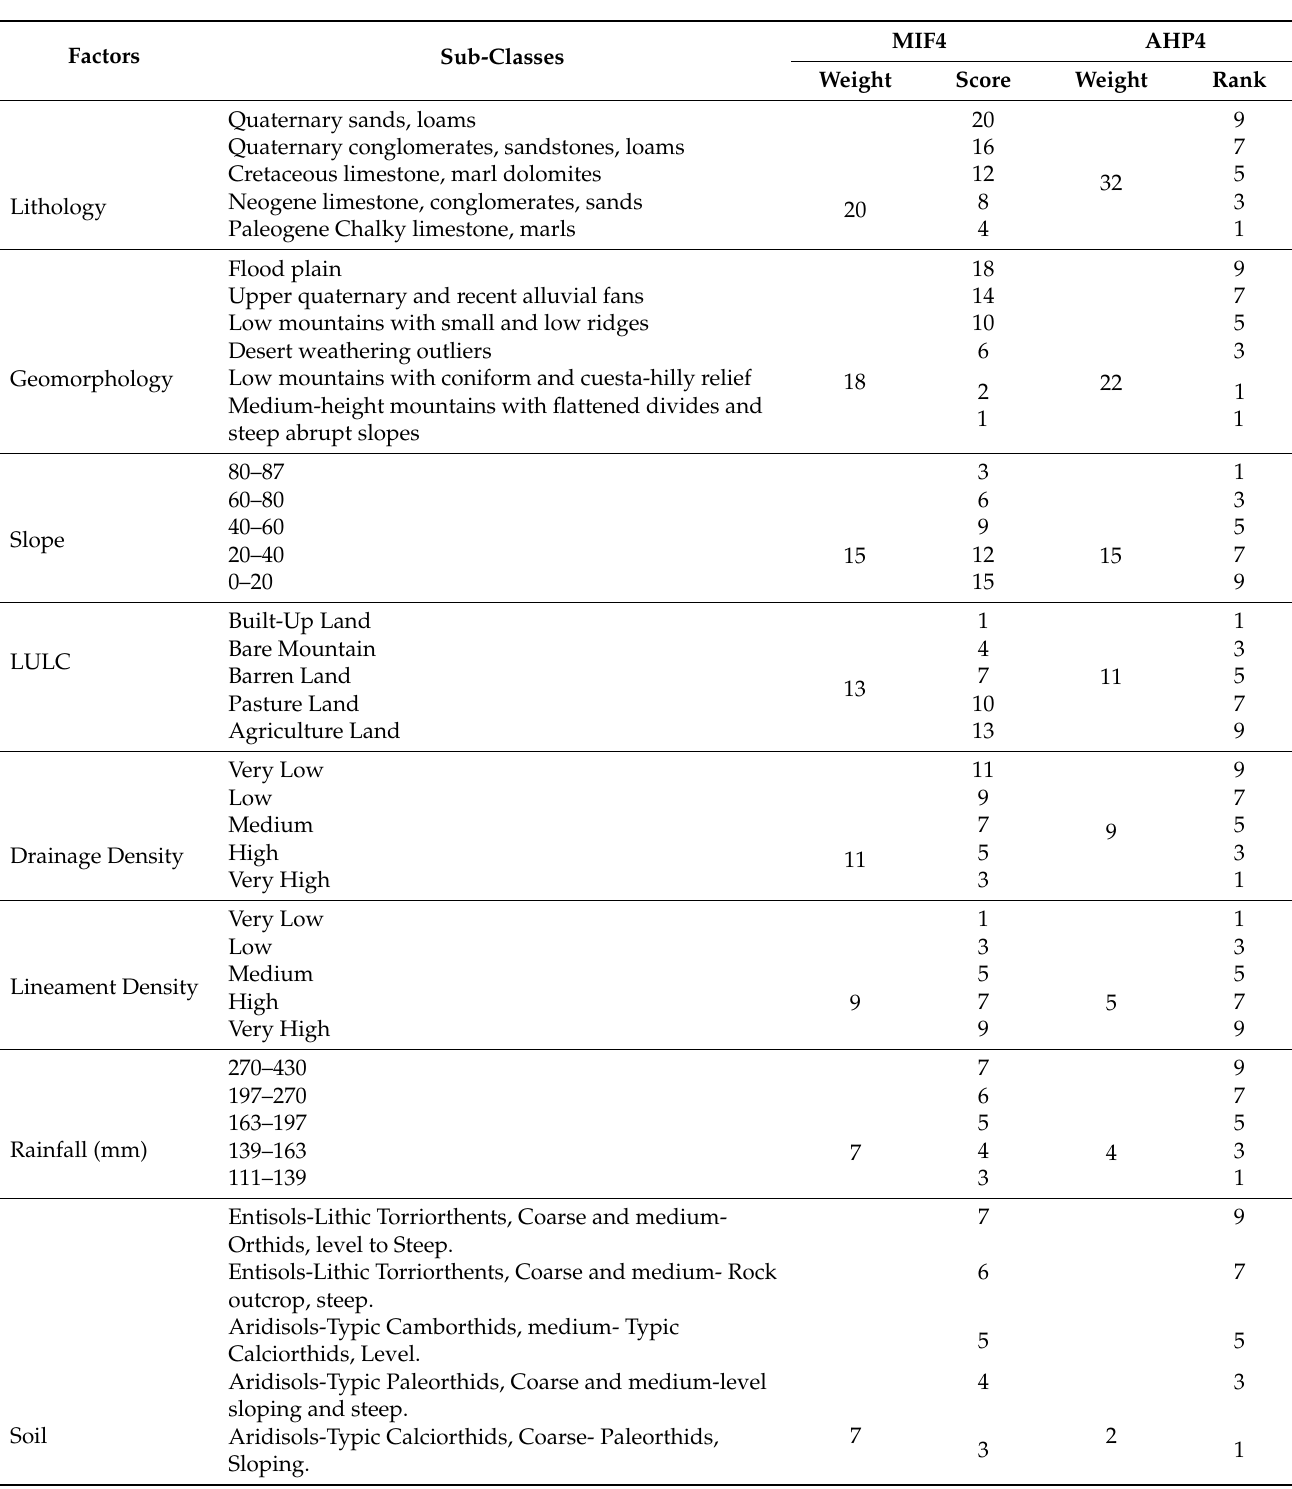
Table A4. Weight and scores of specific characteristics in (MIF4 and AHP4) are assigned to factors that influence